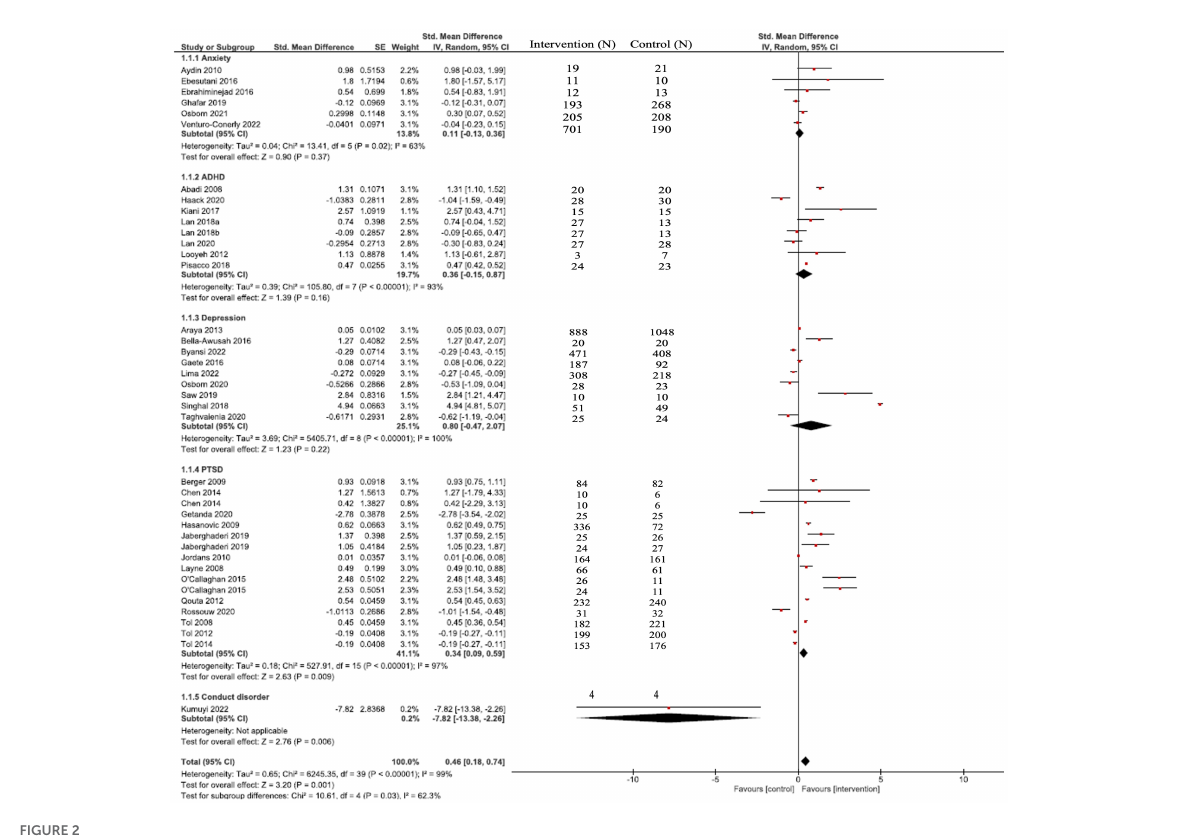
FIGURE2 Forest plot comparing interventions with